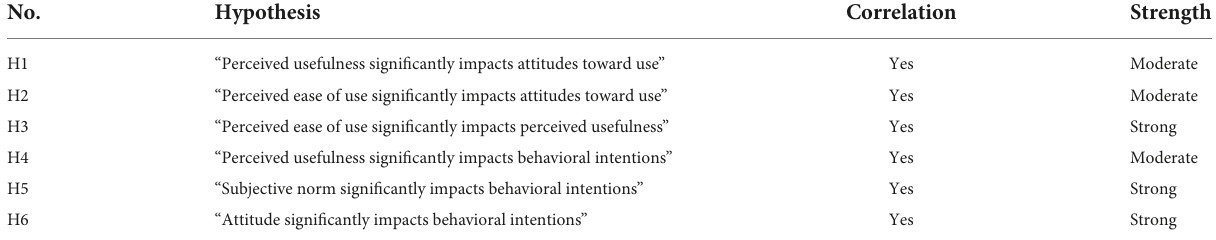
TABLE 2 Results of hypothesis